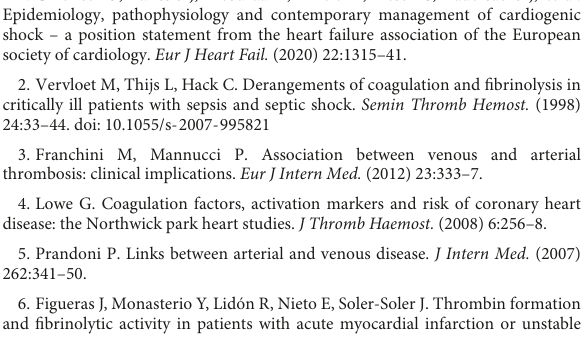
and figure/table development. BS, GM, SC, YW, YZ,